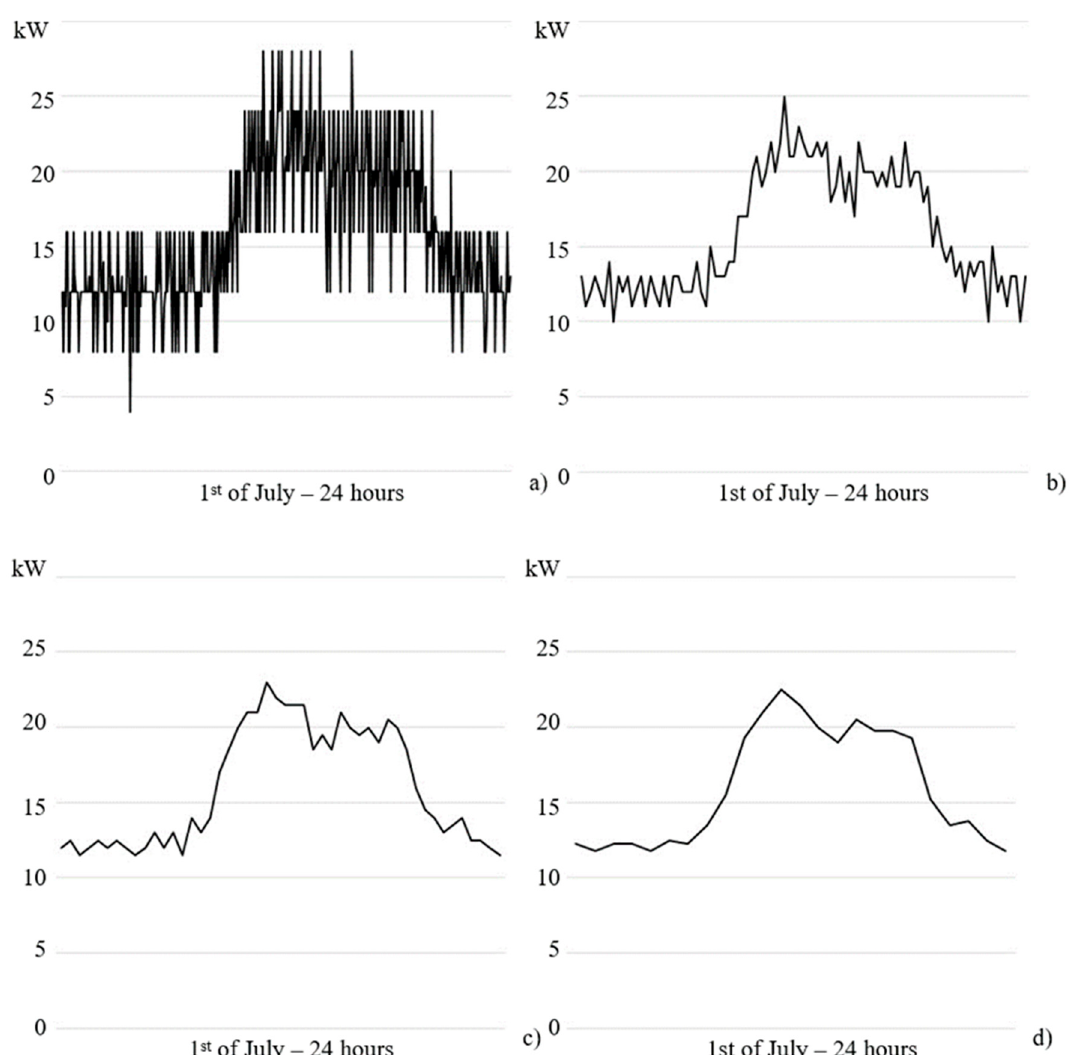
Figure 3. Load profile during the 1st of July for ( a ) 3-min; ( b ) 15-min; ( c ) 30-min; and ( d ) 60-min temporal temporal resolution.